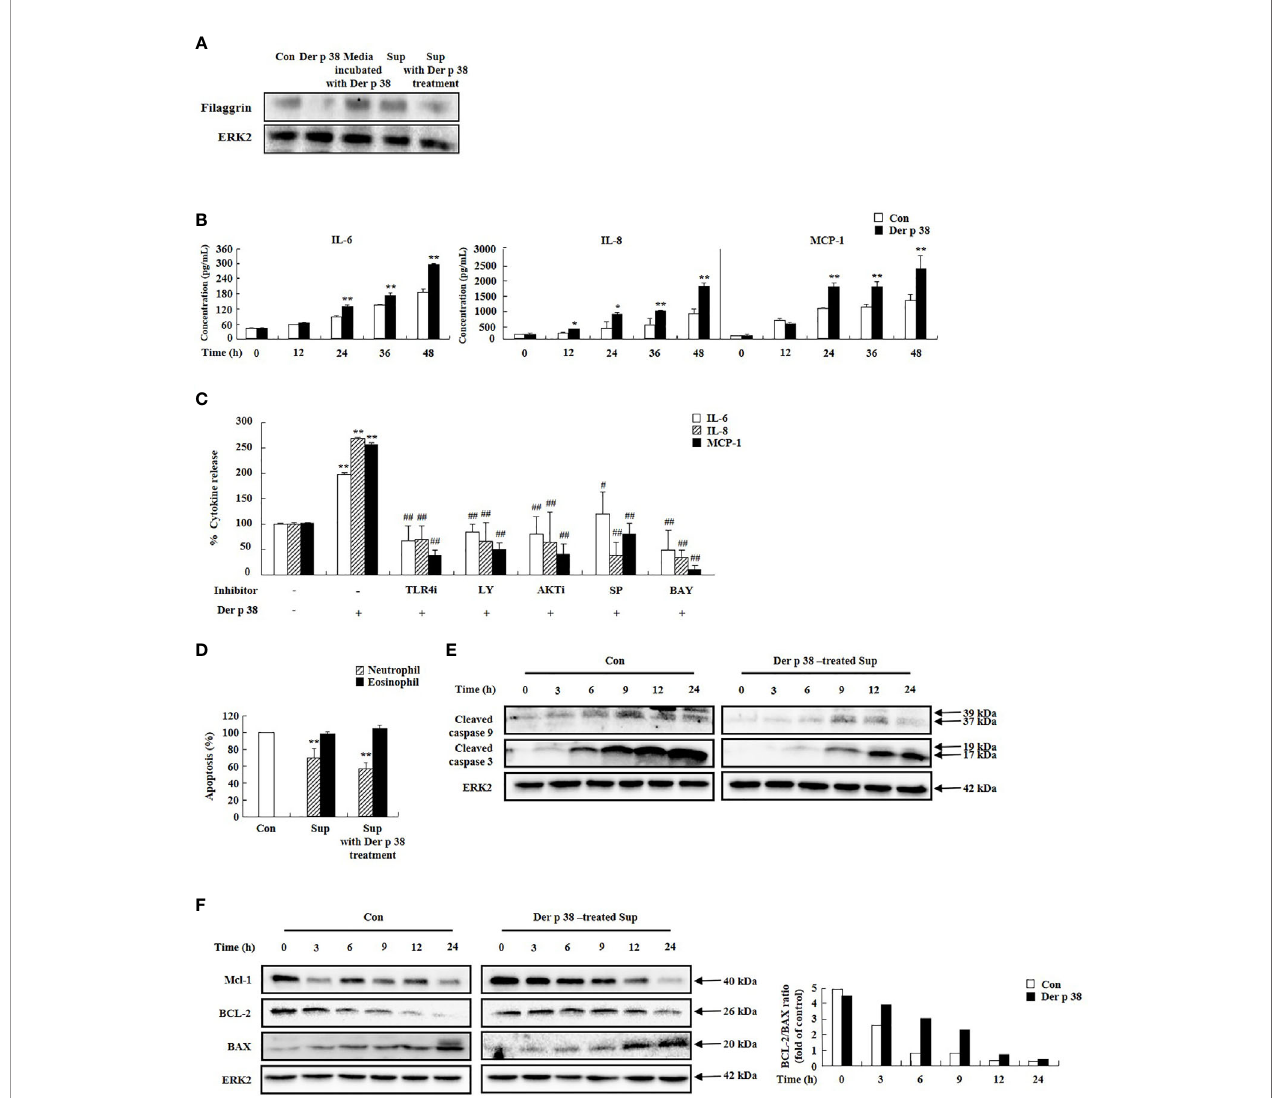
FIGURE 3 | Der p 38 increases cytokine secretion in human keratinocyte HaCaT cells, thereby preventing fi laggrin expression and neutrophil apoptosis. (A) HaCaT cells were treated with 10 m g/mL Der p 38 for 48 h. Supernatant (Sup) was collected, and the other cells were treated with the supernatant for 48 h. The harvested cells were lysed in lysis buffer and the homogenate was centrifugated, and the supernatant was collected as total lysate. Following separation of the protein samples by 10% SDS-PAGE, the transferred nitrocellulose membrane was sequentially incubated with anti- fi laggrin (1:1,000) and secondary antibody (1:3,000) for 1 h at room temperature, and developed using the Enhanced Chemiluminescence Western blotting Detection System. ERK2 expression is used as an internal control. (B, C) Cells were treated with 10 m g/mL Der p 38 for the indicated time (B) , or for 48 h after pretreatment with 2 m M TLR4i, 10 m M LY294002 (LY), 10 m M AKTi, 10 m M SP600125, and 10 m M BAY-11-7085 (BAY) (C) . The supernatant was collected and analyzed by ELISA. (D) Neutrophils and eosinophils were treated with the supernatant after treatment with 10 m g/mL Der p 38. Apoptosis was analyzed by measuring the binding of annexin V-FITC and PI. The data are presented relative to the control, which was set at 100% as the mean ± S.D (n=3). * p < 0.05 and ** p < 0.01 indicate a signi fi cant difference between the untreated and Der p 38-treated groups, and # p < 0.05 and ## p < 0.01 indicate signi fi cant difference between the Der p 38-treated group and the inhibitor-treated groups. (E, F) Activation and expression of the indicated signal proteins were evaluated by Western blotting. Lower panel (F) is the ratio of BCL- 2/BAX using